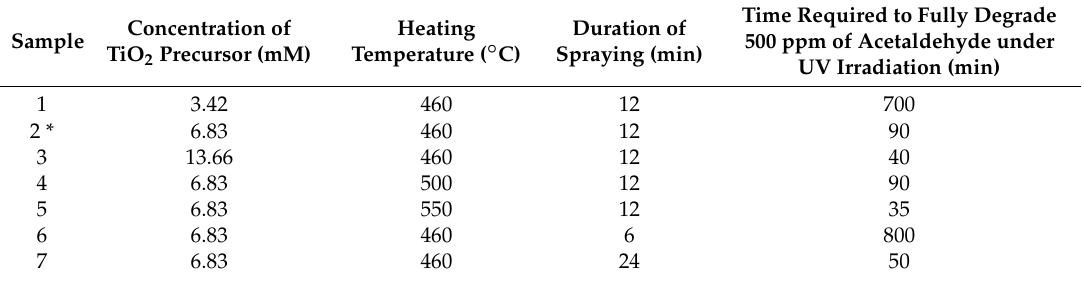
Table 2. Photocatalytic decomposition of acetaldehyde by using TiO 2 on stainless steel prepared by Spray-ILGAR technique using different concentrations of TiO 2 precursor, different heating temperatures and different spraying durations.